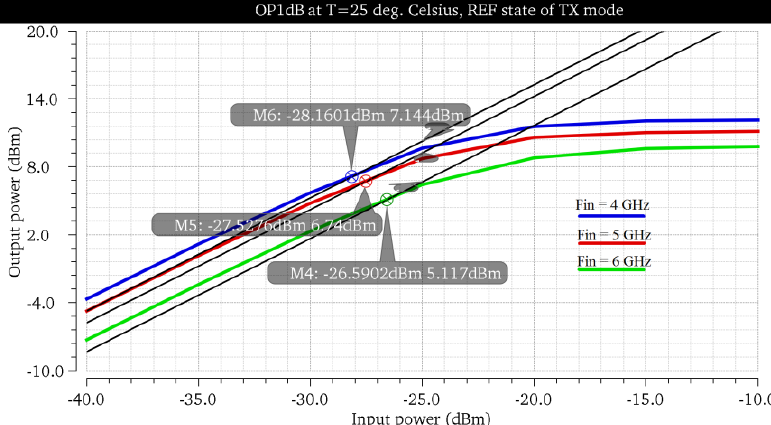
Fig. 9. Frequency dependence of the absolute attenuation error from the control code in Tx mode.